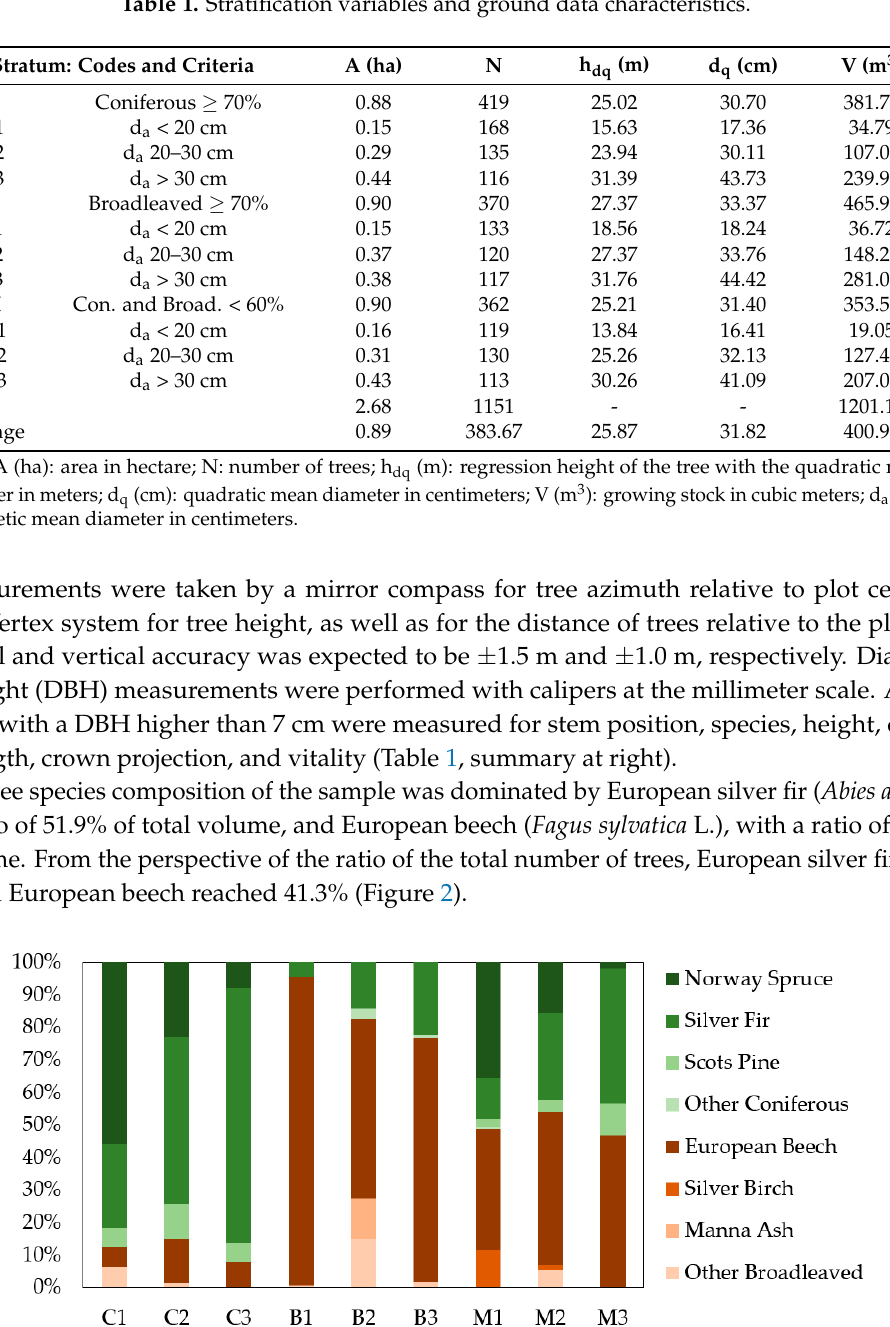
Table 1. Stratification variables and ground data characteristics.